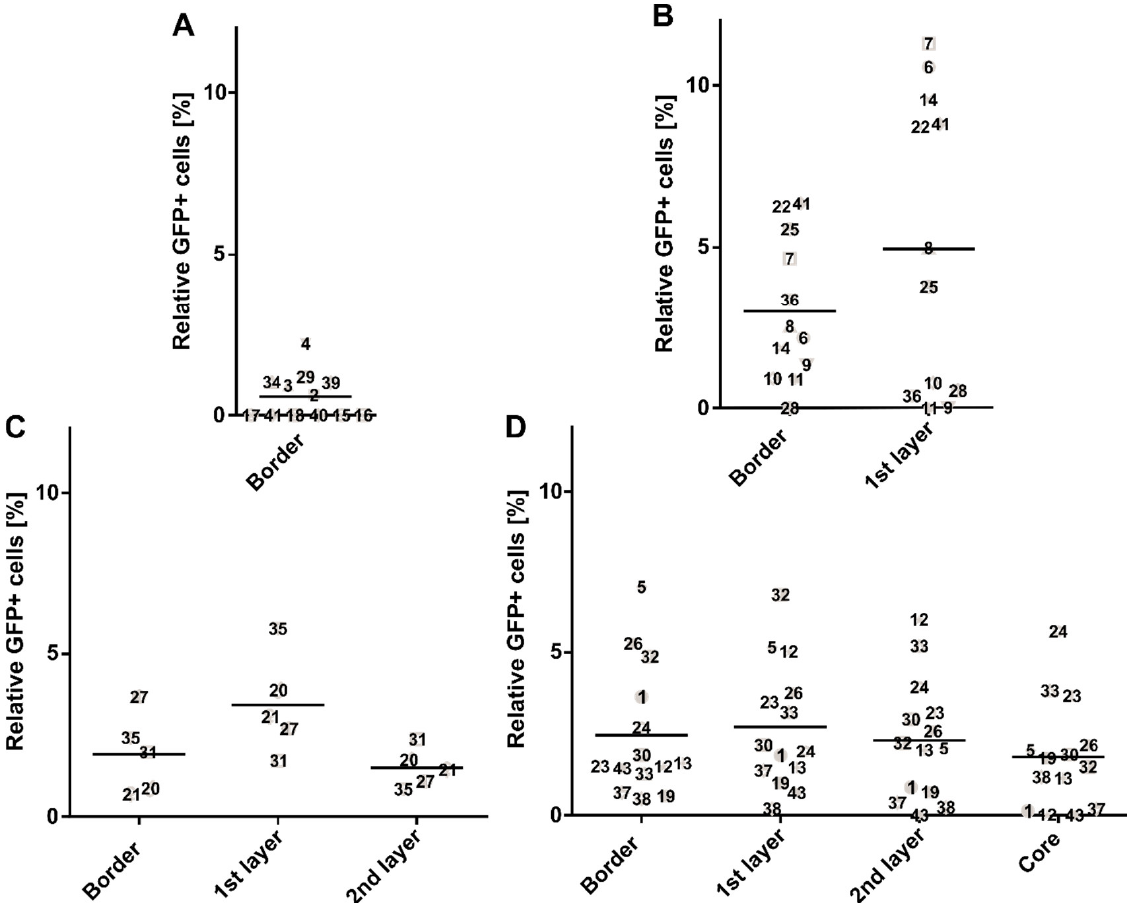
Figure 5. Transduction of all tumor layers by AAV2 vector in TGFα/c-myc HCC mice. Tumor-bearing animals were i.v.-injected with scAAV2.CMV.eGFP. Vector dose: 1 × 10 11 particles per animal.